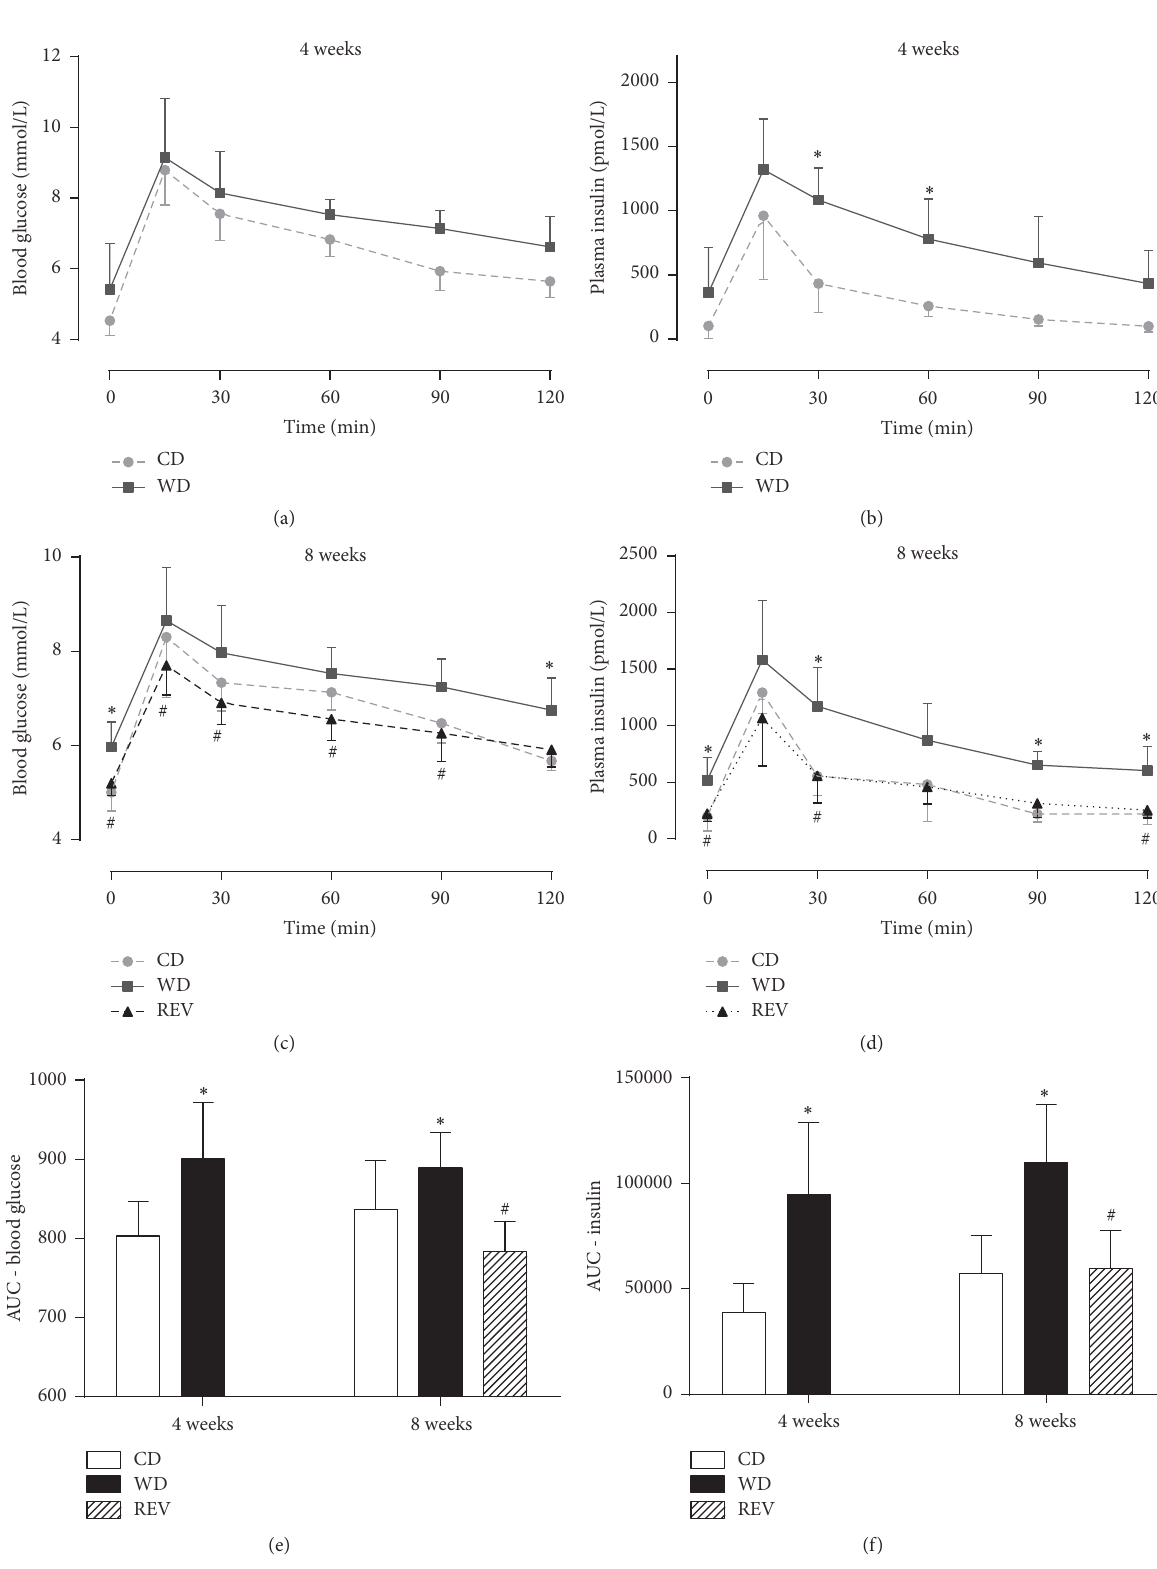
Figure 2: Glucose tolerance after diet feeding without sevoflurane exposure. Blood glucose (a, c), insulin (b, d) levels, and area under the curve (AUC; e, f) during an oral glucose tolerance test in rats after 4 and 8 weeks of control diet (CD), western diet (WD), or diet reversion (REV) feeding. Data are mean ± SD, 𝑛 = 6 , Student’s 𝑡 -test, one- and two-way ANOVA with repeated measures, and Bonferroni post hoc analyses, ∗ 𝑝 < 0.05 versus CD and # 𝑝 < 0.05 versus